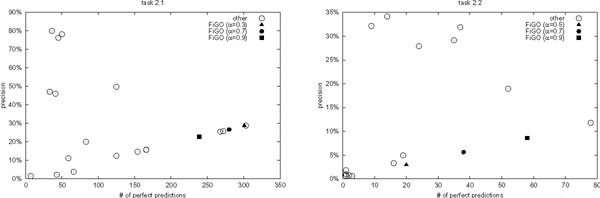
Performance of all the submissions in tasks 2.1 and 2.2. These charts compare the quality of the predictions returned by FiGO with all the other submissions to BioCreative tasks 2.1 and 2.2. For each submission, the charts show the precision versus the number of perfect predictions identified. The precision is the number of perfect predictions over the number of predictions submitted.